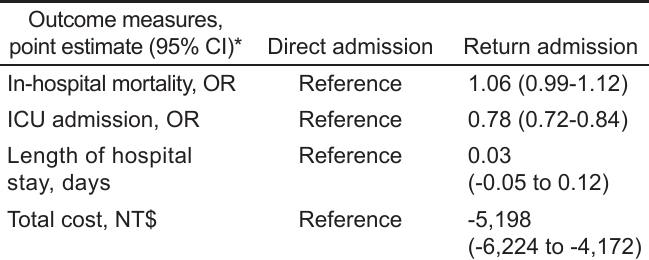
Table 4. Study outcomes by revisit status, adjusted.